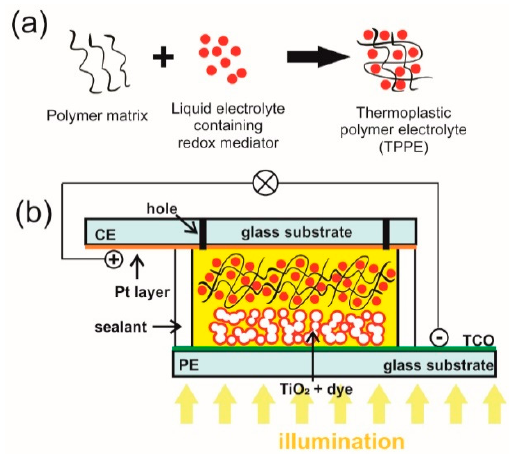
Figure 10. Schematic illustrations of ( a ) swelling the polymer network with liquid electrolyte containig the redox mediator such as presented in ref [212] and ( b ) Schemcatic illustration of a DSSC containing the gel electrolyte such as described in ref